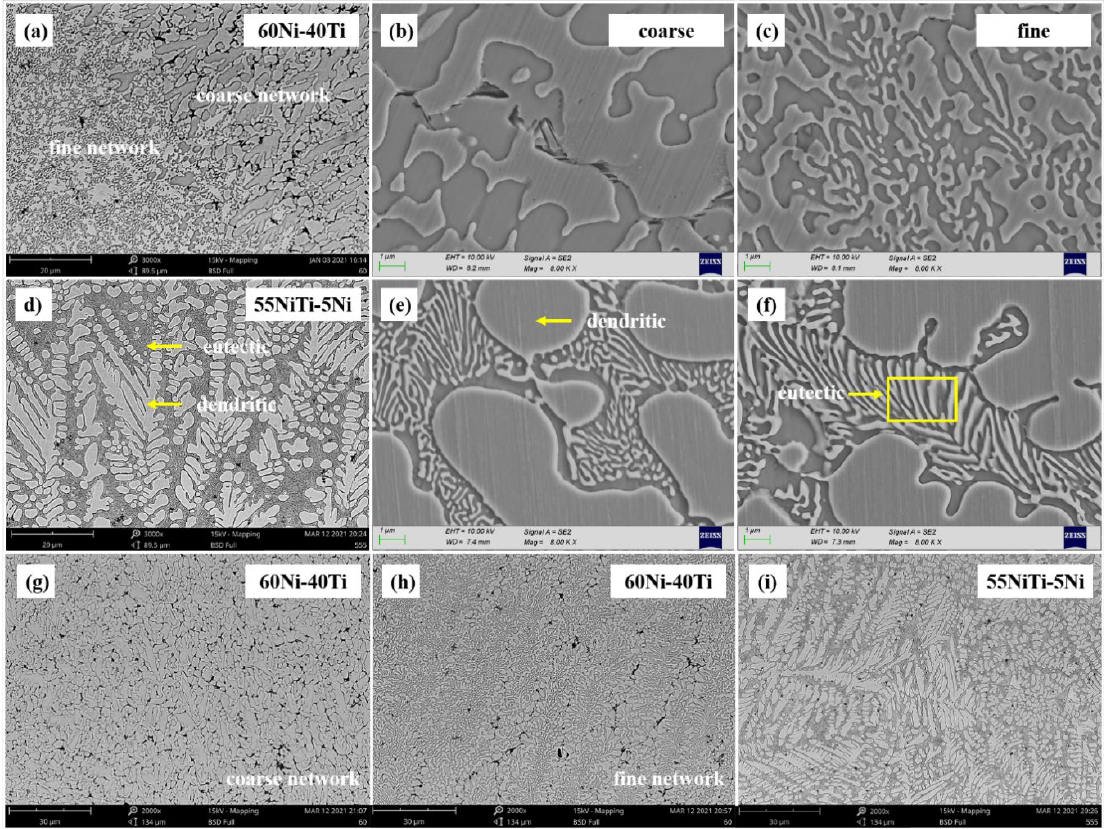
Figure 5. Backscattered electron (BSE) and SEM images of the microstructure of coatings: ( a )–( c ) 60Ni-40Ti; ( b )–( f ) 55NiTi-5Ni; BSE images of coatings at low magnifications to compare grain size: ( g )–( i ).